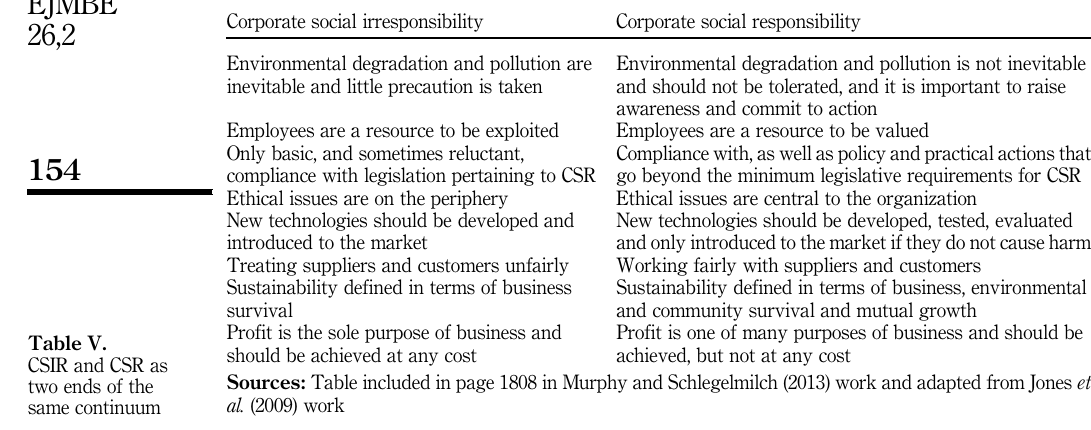
Table V. CSIR and CSR as two ends of the same